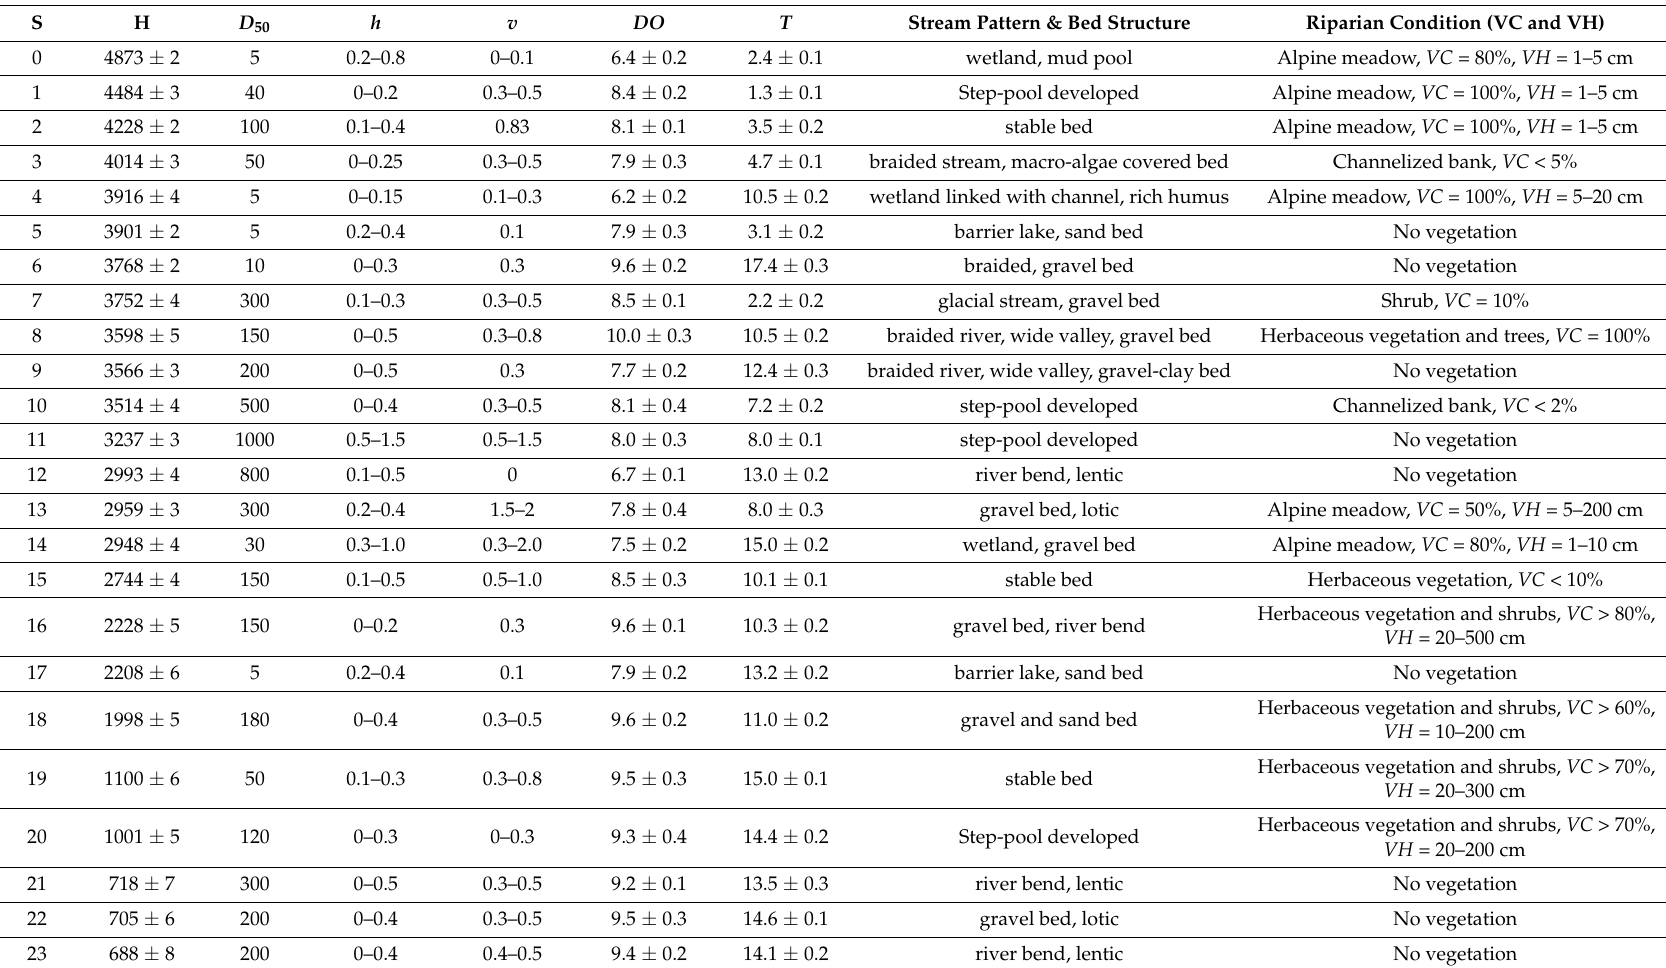
Table 7. Means ( ± SE) and ranges of environmental parameters of the sites in the Yalutsangpo